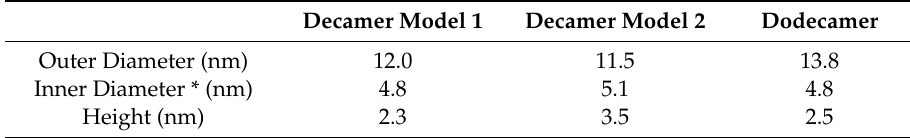
Table 3. Structural parameters of models of the stab-1 HCC oligomers after MD